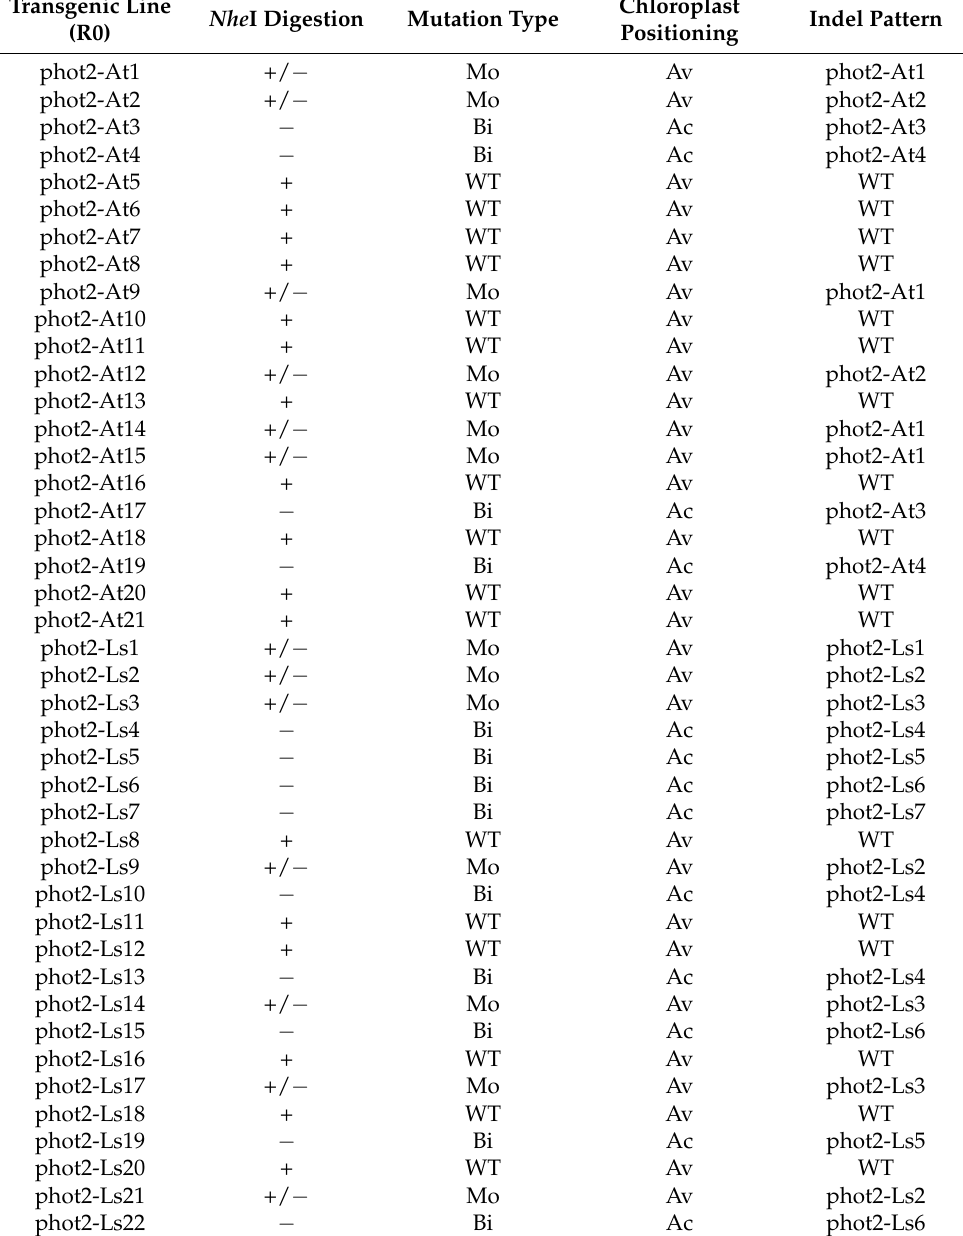
Table 1. Genotype and phenotype of R0 phot2-At and phot2-Ls transgenic lines. Nhe I digestion: +, digested; − , not digested; +/ − , partially digested. Mutation type: WT, no mutation; Mo, monoallelic mutation; Bi, biallelic mutation. Chloroplast positionings were examined after irradiation with a high- intensity blue light (50 µ mol m − 2 s − 1 ) for 2 h Ac, accumulation; Av, avoidance. Indel patterns were summarized on the basis of data from Nhe I digestion and DNA sequencing, as shown in Figure